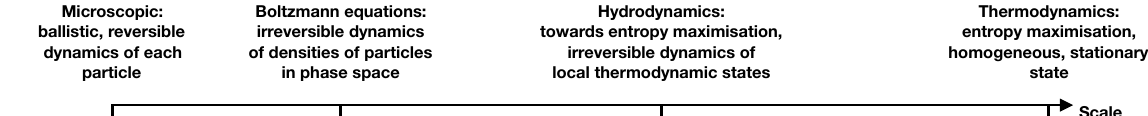
Figure 2: Time scales in gases with their various theoretical